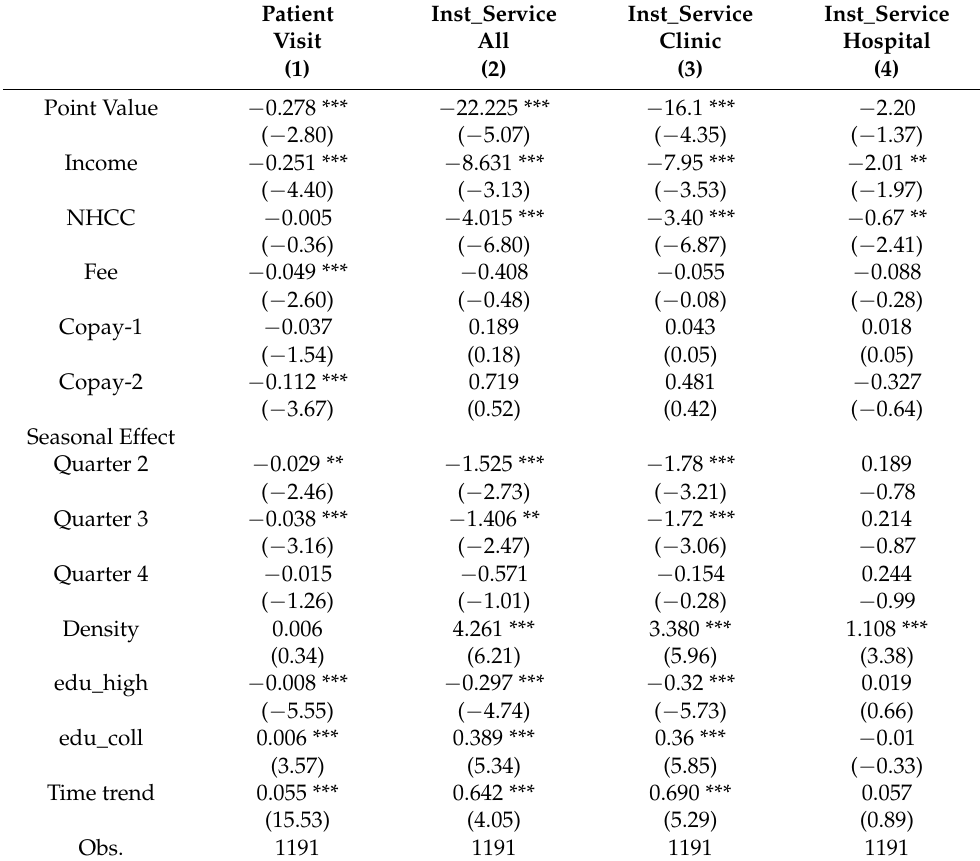
Table 5. GLS Regression Analyses for Number of Office Visits–District Aggregate